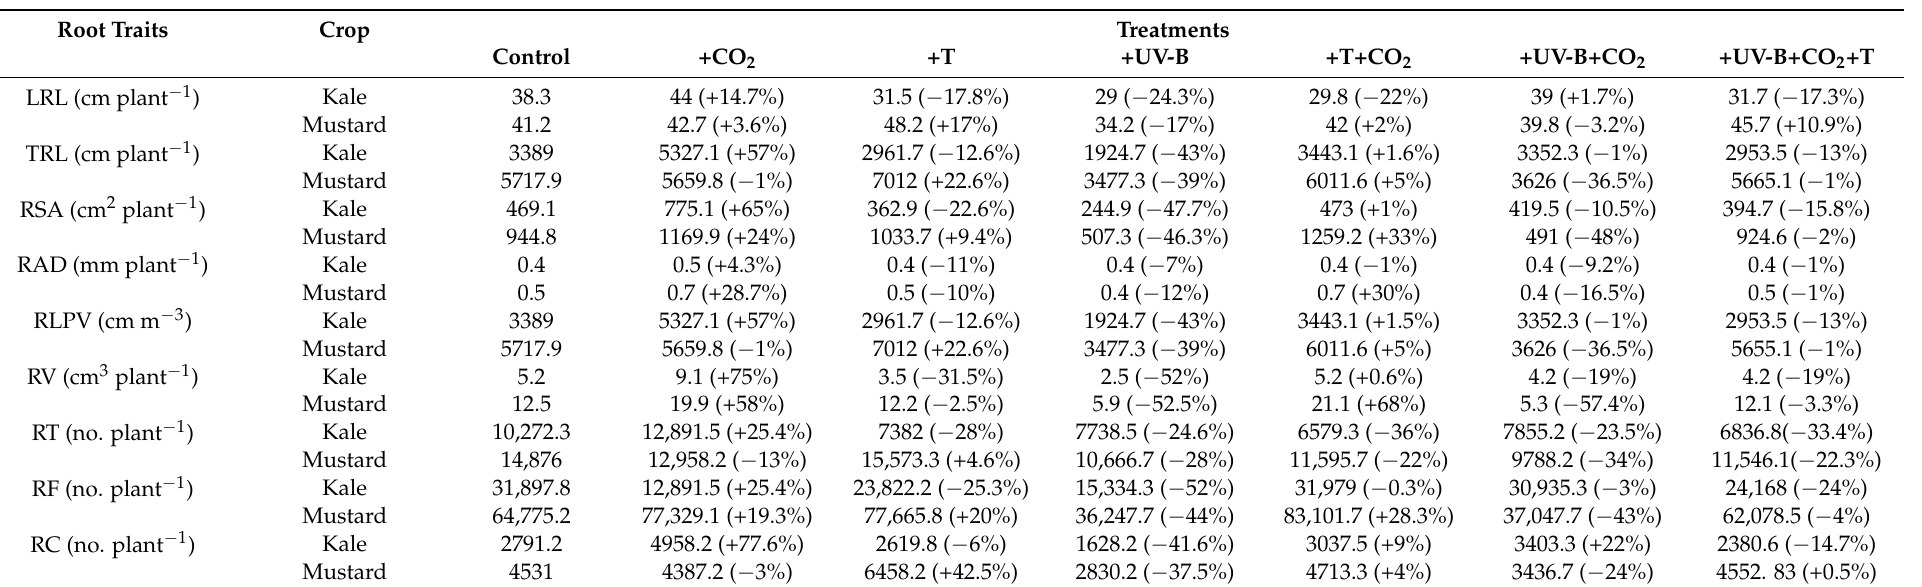
Table 4. Mean values and percent change for the longest root length (LRL), total root length (TRL), root surface area (RSA), average root diameter (RAD), root length per volume (RLPV), root volume (RV), number of root tips (RT), number of root forks (RF) and number of root crossings (RC) measured under CO 2